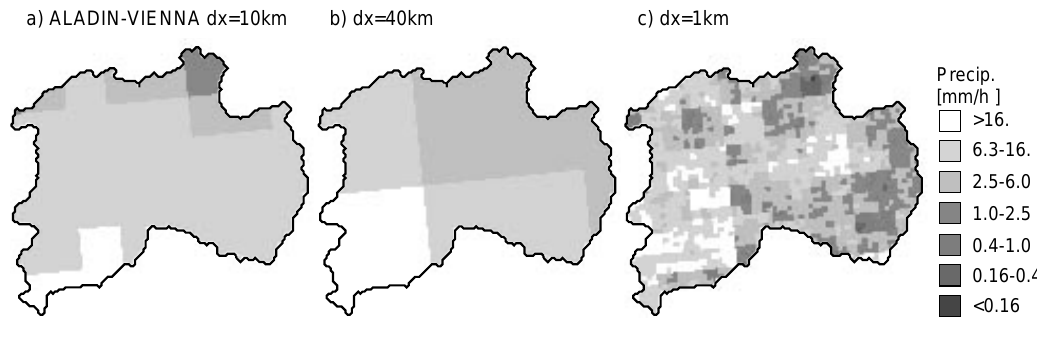
Fig. 6. Hourly accumulated precipitation products by ALADIN-VIENNA for 20 September 1999, 12:00 to 13:00UTC in mm/h, (a) the simulated precipitation field with numerical grid spacing of 10km, (b) an upscaled version on a grid with 40km grid spacing and (c) a stochastically downscaled field with 1km grid spacing.